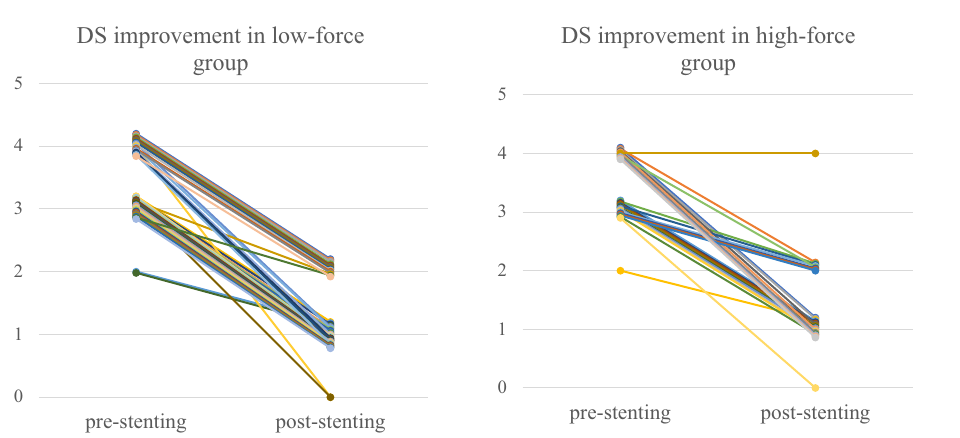
Figure 2. Degree of dysphagia score improvement in two